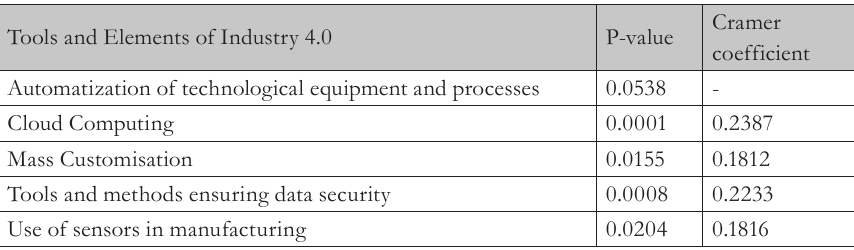
Tab. 6 – Results of tested hypotheses. Source: Survey questionnaire Tools and Elements of Industry